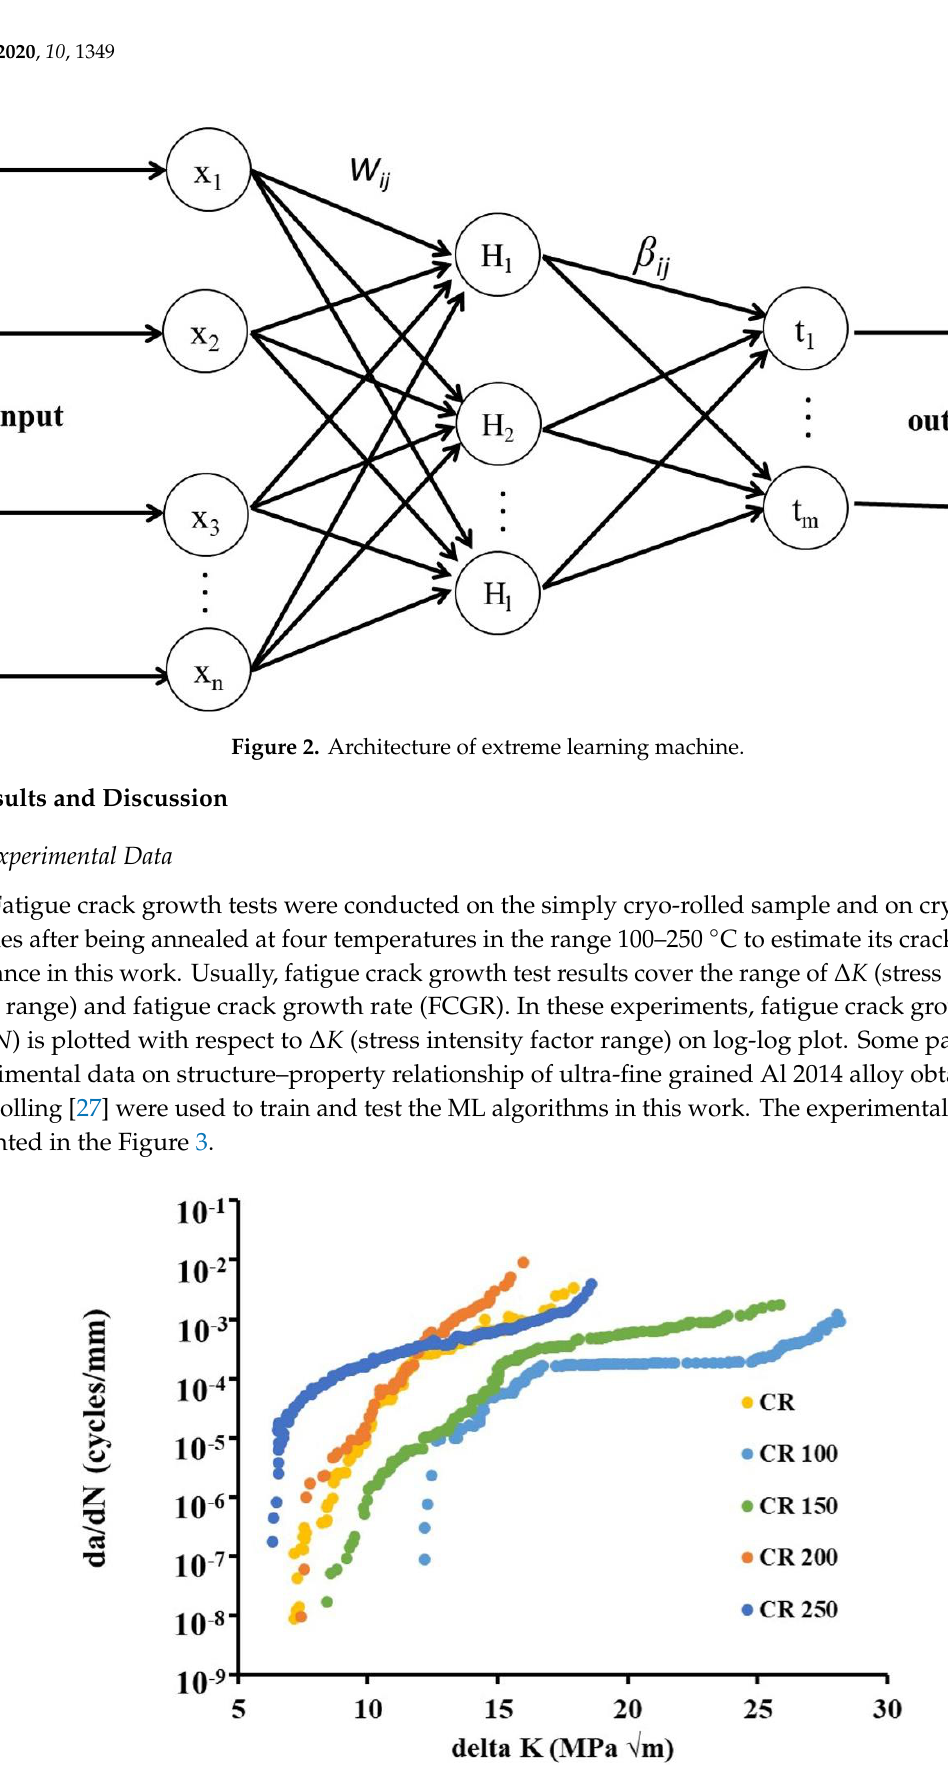
Figure 3. Fatigue crack growth rate (FCGR) experimental data of cryo-rolled Al 2014 alloy [27]. The experimental data correspond to the simply cryo-rolled (CR) sample and the cryo-rolled samples after annealing. As the CR 250 sample exhibited smooth Paris law regime, the data of these samples were used to train the algorithms; while the data of the other samples CR, CR100, CR150 and CR200 are used to test the trained algorithms. In the present investigation, the fatigue crack growth test results for cryo-rolled and annealed samples after cryo-rolling showed two important findings: (i) Fatigue crack growth resistance of bulk UFG Al 2014 alloy developed by CR exhibited lower fatigue crack growth resistance and higher crack initiation stress intensity factor Δ K th as compared to the ST alloy; (ii) on annealing, the fatigue crack growth resistance and crack initiation stress intensity factor Δ K th improved compared to the CR alloy. The maximum resistance to crack growth was imparted by CR100 sample which was annealed at 100 °C after cryo-rolling. 3.2. Machine Learning We tried to predict the material constants by using ML algorithms. Considering the complexity involved in modelling the relationship between crack growth rate (d a /d N ) and stress intensity factor range (∆ K ) which are not linear even in the Paris region as well as diverse effects of stress ratio on different materials, most existing models cannot capture these non-linearities. However, most recently, to fit any type of data with being flexibility and adaptability as its strengths, machine learning algorithms handle the non-linear relationships elegantly. In fact, algorithms like principal component analysis can capture the hidden factors responsible for certain phenomenon. Thus, machine learning method provides an alternative and flexible approach for modelling of fatigue crack growth rate because of their non-linear approximation and multivariable learning ability which makes it advanced and promising. The tests to evaluate the trained models were implemented over different dataset. Back Propagation Neural Networks Overfitting is a modelling error that occurs when a function is too closely fit to a limited set of data points. It occurs when a model learns the detail and noise in the training data in such a way that it predicts the particular set of data exactly but fails to predict a new set of data. This means, overfitting is defined by low bias in the parameters but with high sampling variance. Overfitting is an issue, as there are very few theories available to guide the analysis.